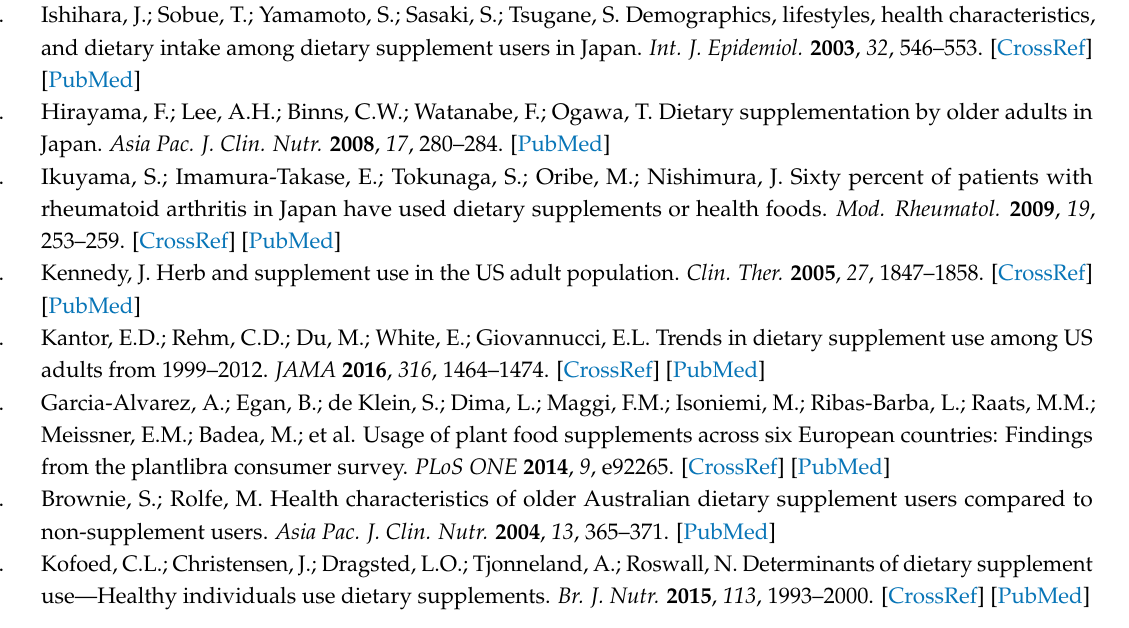
Table S1: Preliminary Survey, Table S2: Full